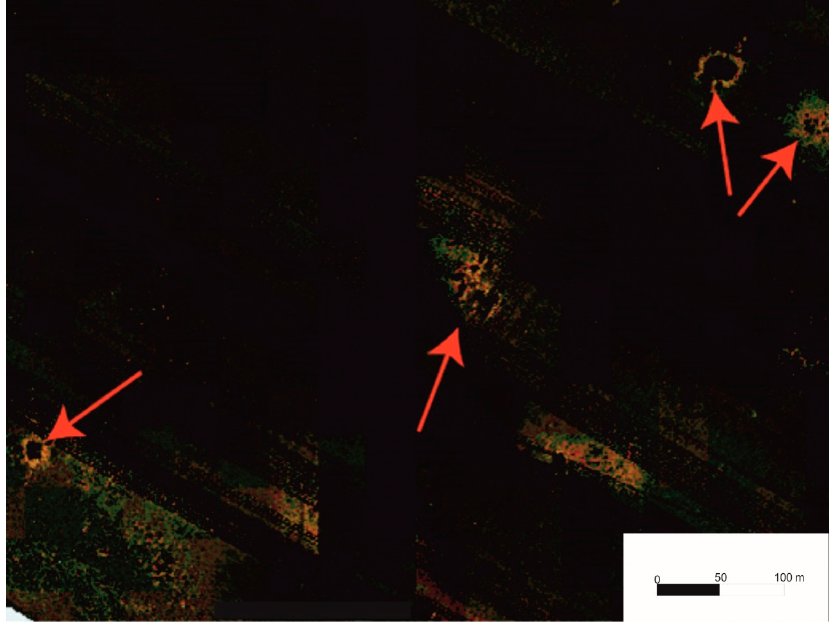
Figure 14. Sonogram of a pockmarks field in the bottom of the Petrozavodsk Bay (the position, see Figure 1).